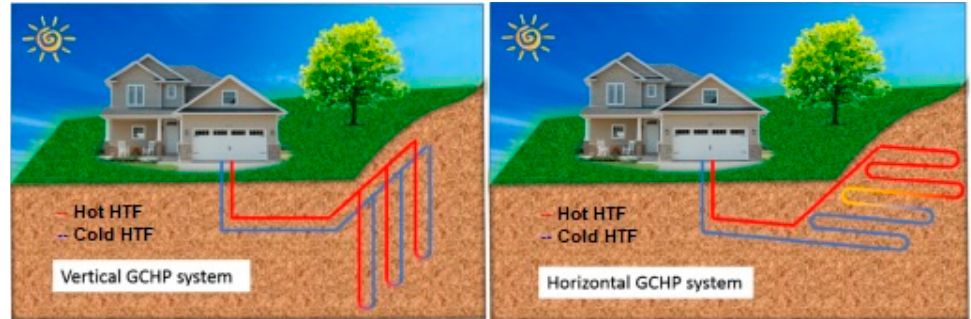
Figure 8. Horizontal and vertical ground heat exchanger (GHE) system configuration.